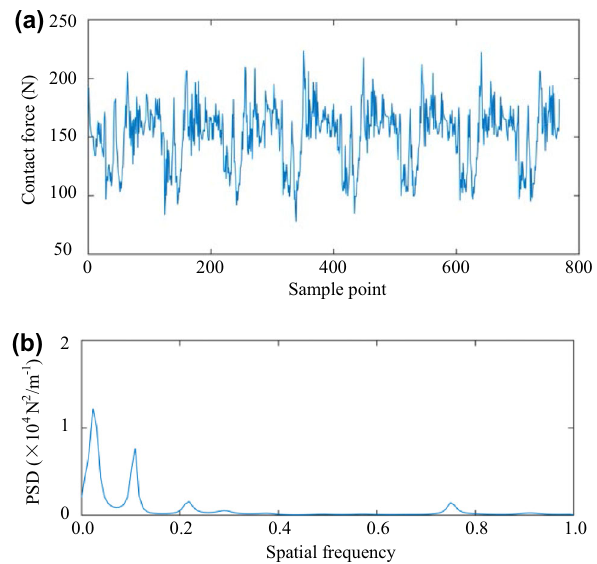
Fig. 15 Contact force simulation signal ( a ) and its PSD valuation ( b )